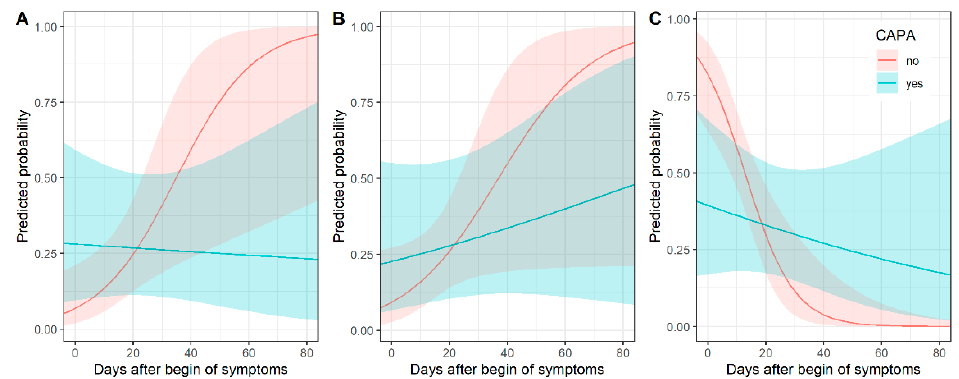
Figure 2. Chronological changes in CT (predicted probabilities) of consolidation ( A ), crazy paving ( B ) and ground glass opacity ( C ) for patients with and without COVID-19-associated pulmonary aspergillosis (CAPA) with corresponding 95% confidence intervals. In early COVID-19 disease, consolidation was associated with CAPA, whereas ground glass opacity was less common.